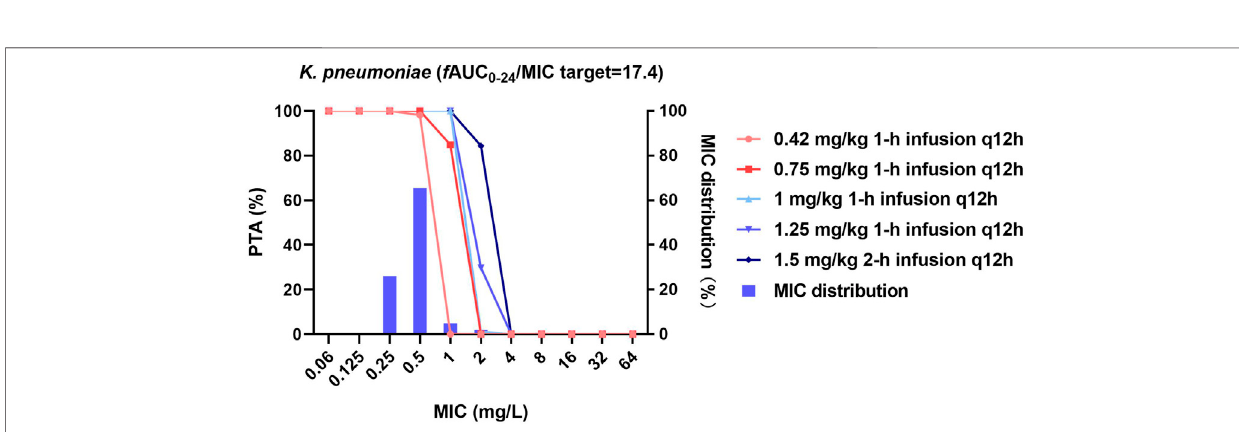
Frontiers in Pharmacology |